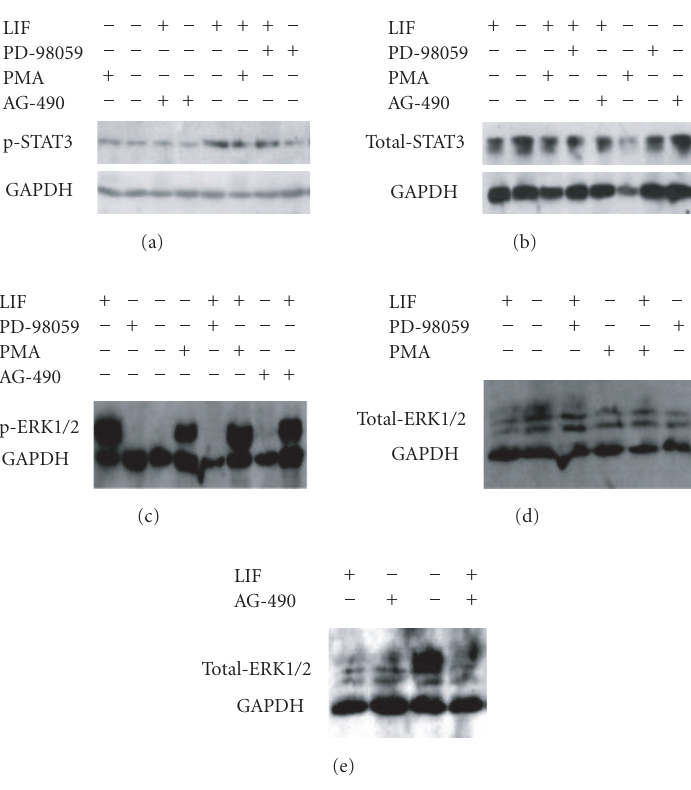
Figure 2: E ff ects of AG-490, PD-98059, or PMA on LIF-induced activation of signal transduction and activation of transcription (STAT3) and ERK1/2 . Western blot was performed on NHBE cells that had been preincubated with or without AG-490, PD-98059, or PMA and then stimulated with LIF. (a) LIF induced activation of tyrosine phosphorylation of STAT3, and tyrosine phosphorylation of STAT3 was inhibited by AG-490, but not by PD-98059, and not a ff ected by PMA. (b) LIF did not enhance the expression of total-STAT3, and its expression was not a ff ected by AG-490, PD-98059, and PMA. (c) LIF induced activation of phosphorylation of ERK1/2, and ERK1/2 activation was inhibited by PD-98059, but not by AG-490; PMA increased the expression of p-ERK1/2 in NHBE cells, but there were no significant di ff erences between the cells stimulated with LIF and the cells stimulated with LIF in the presence of PMA. (d) and (e) LIF did not enhance the expression of total-ERK1/2, furthermore, AG-490, PD-98059, and PMA also did not a ff ect it. Experiments were repeated three times with similar results, and the data was expressed as the mean ratio (target/GAPDH) ±